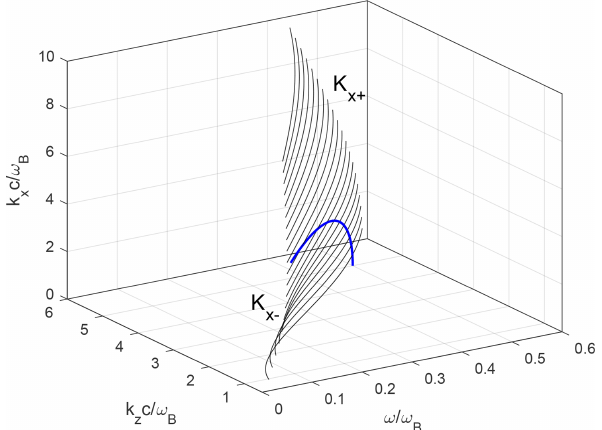
Figure 1. Dependence of the transverse component of the wave vec- tor on the frequency and the longitudinal component of the wave vector for (ω p /ω B ) 2 = 25 are shown by contours with constant k x in the surface k x = k x (ω,k z ) . Two branches K x − and K x + (see Eq. 2) are separated by a blue